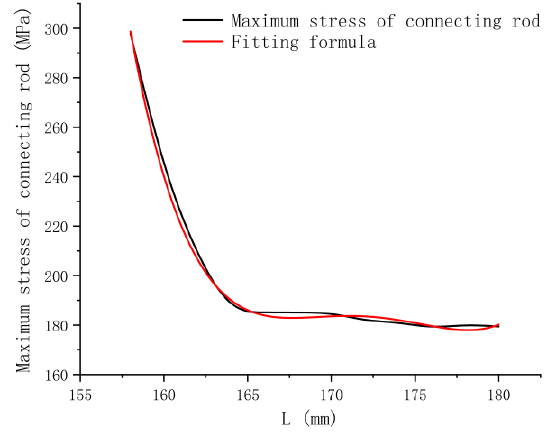
Figure 22. The influence curve of the long diameter of rod section on the maximum stress of connecting rod is compared with the formula curve after iteration.